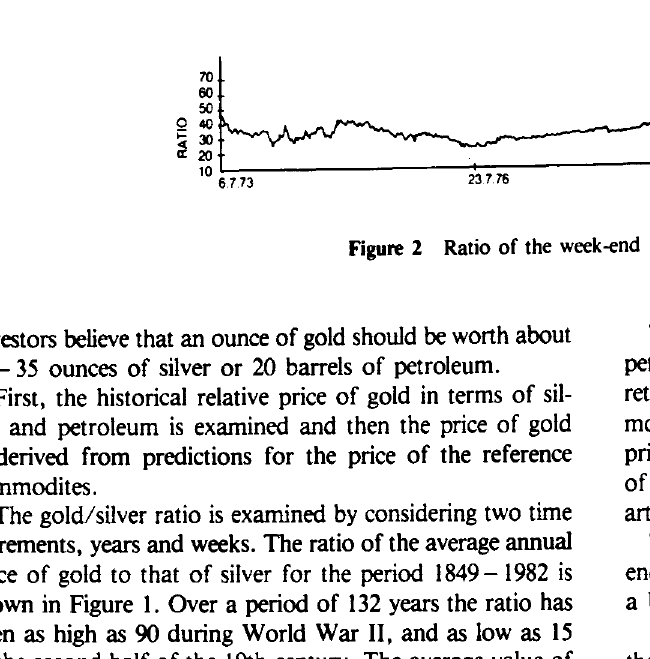
Figure 2 Ratio of the week-end fixings of gold and